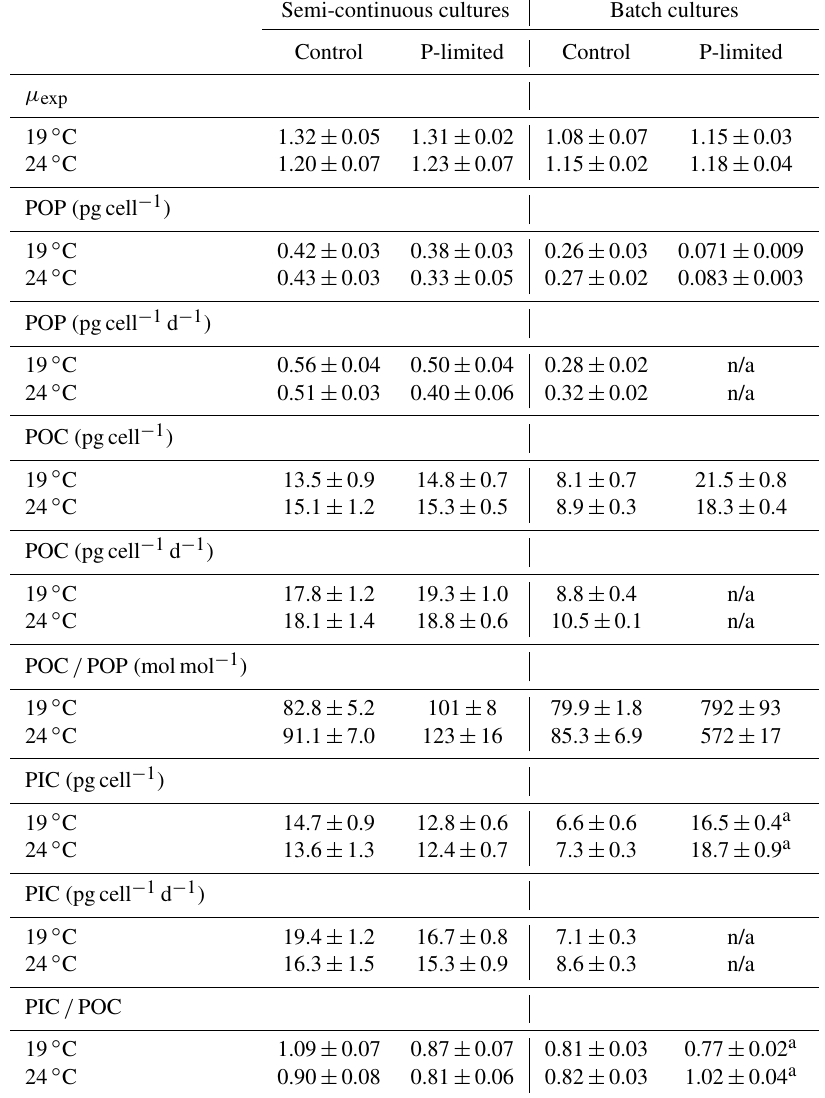
Table 4. µ exp , POP, POC and PIC cellular content, production and ratios in semi-continuous and batch control and P-limited cultures of Emiliania huxleyi grown at 19 and 24 ◦ C; n = 3 ± standard deviation.